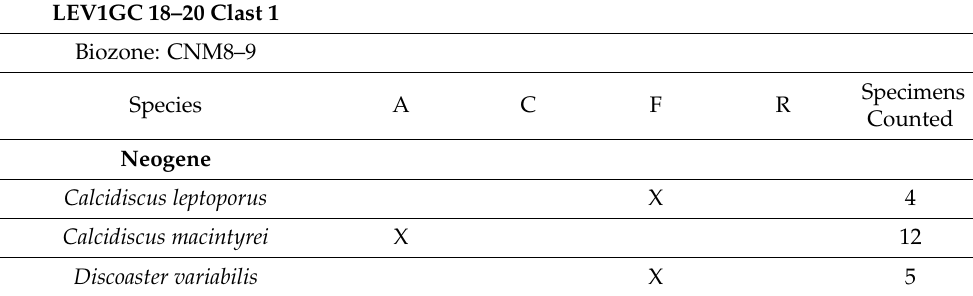
Table A10. Gelendzhik